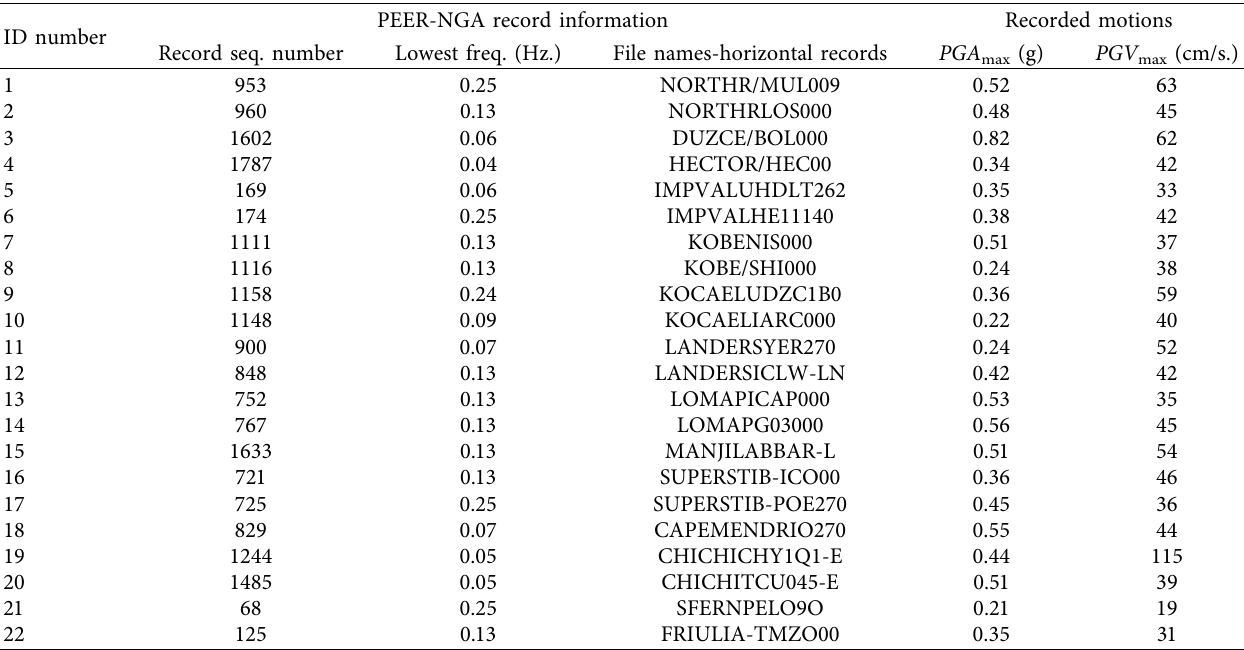
Figure 21: Relative displacement on top of the cylinder under the combined action of earthquakes and waves and under the HECTOR earthquake (ID number 4 in Table 2). Table 2: Details of the ground